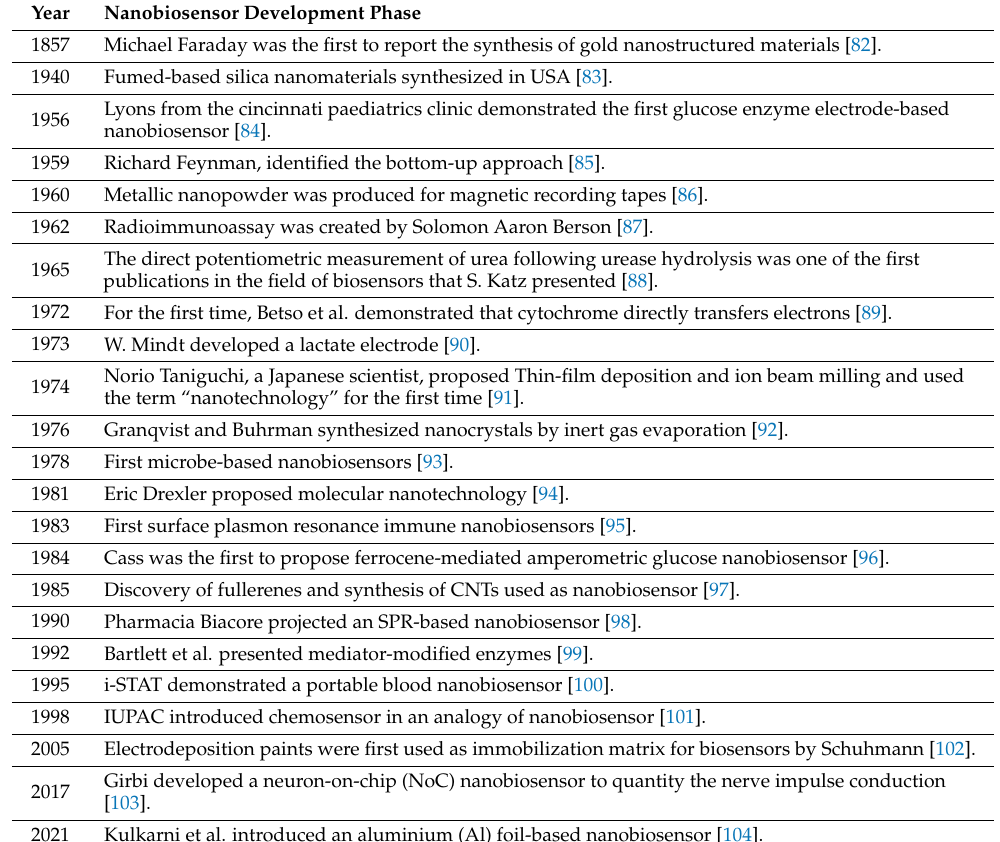
Table 3. Evolution of the development of